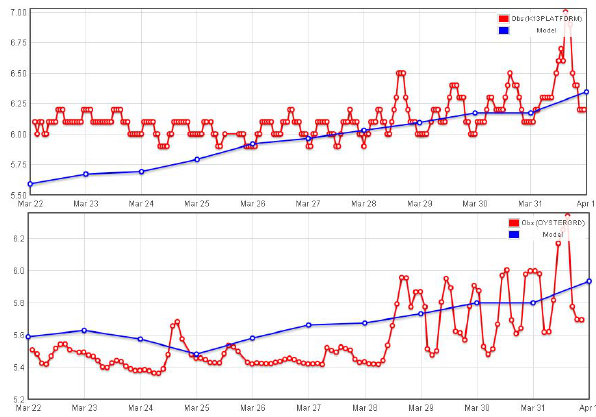
Fig. 7. Zoomed in timesereies from Fig. 5 of sea water tempera- ture ( ◦ C) showing diurnal and tidal variation in the K13 observing platform and MRCS model (upper panel). Also comparing with the OysterGround SmartBuoy to the north east of the K13 platform (lower